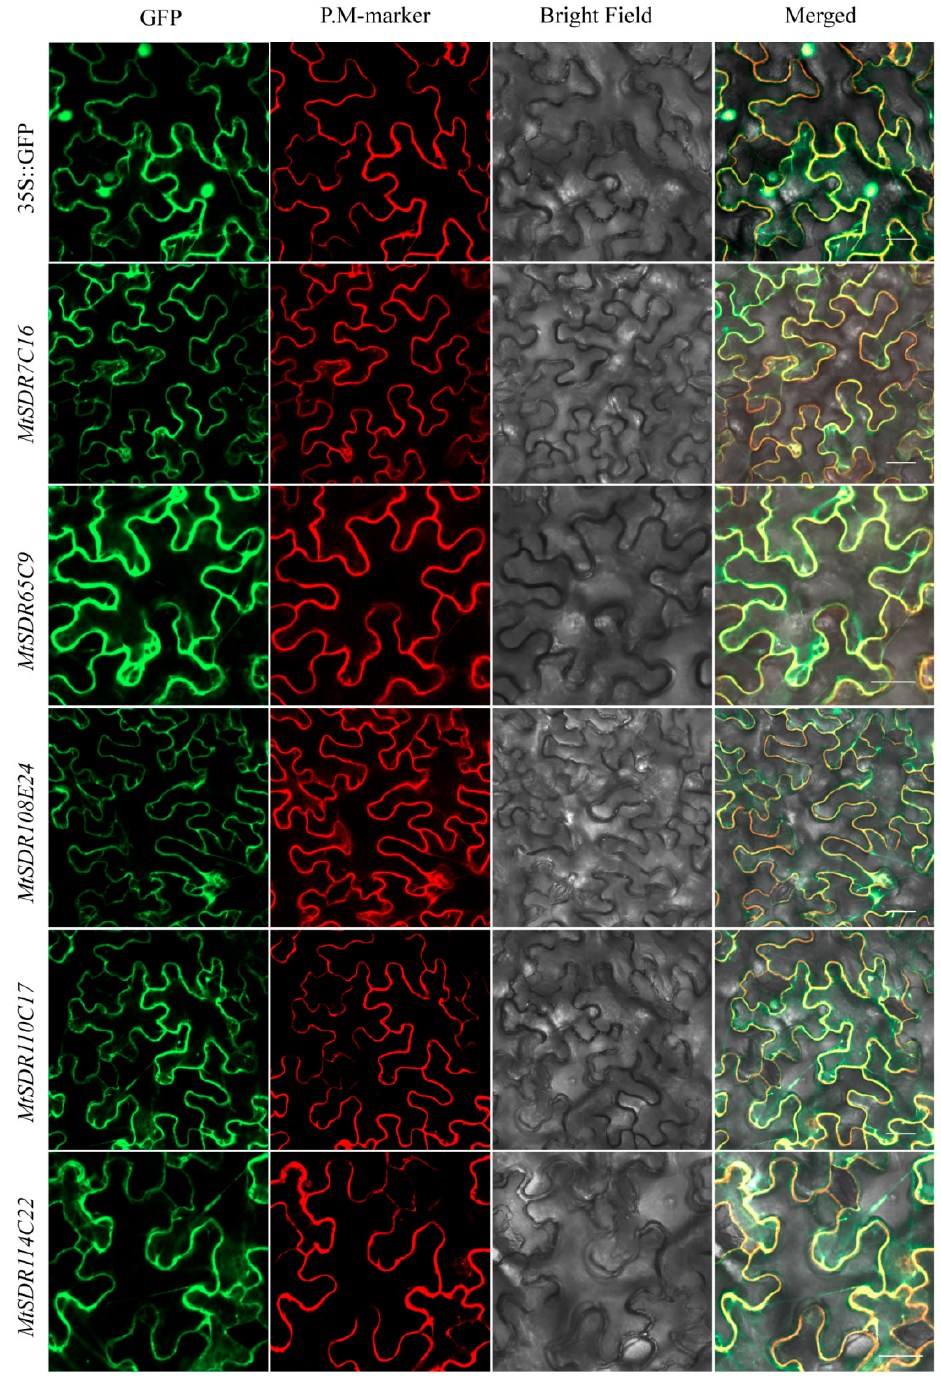
Figure 9. Subcellular localization of MtSDRs. The injected tobacco was used for observation. PM-marker: plasma mem- marker: plasma membrane localization protein AtAKT1. Bars = 20 µ brane localization protein AtAKT1. Bars = 20 µm.